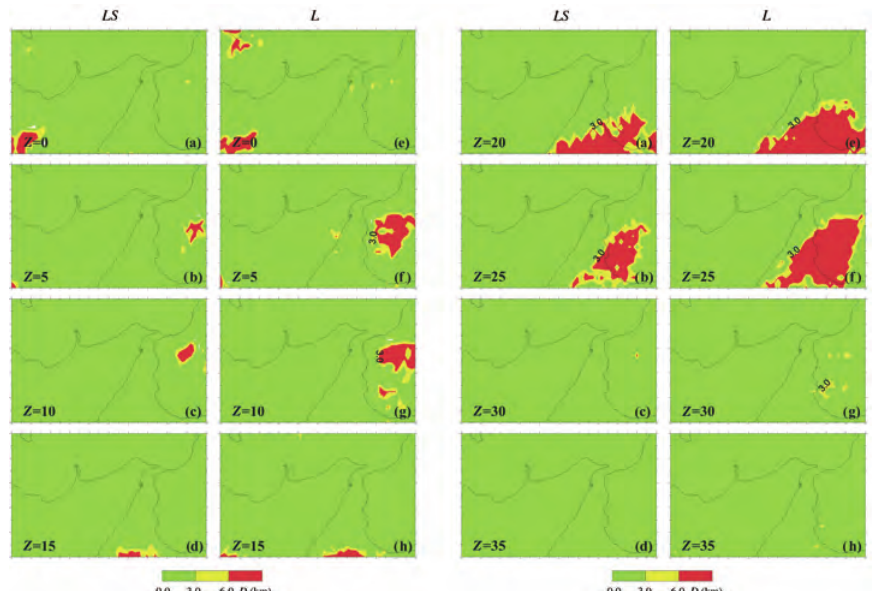
Fig. 9. Comparison of D -parameter horizontal distributions at different depths like in fig. 7. The standard de- viation of the random noise perturbation of synthetic arrival times is reduced to 0.05 s.